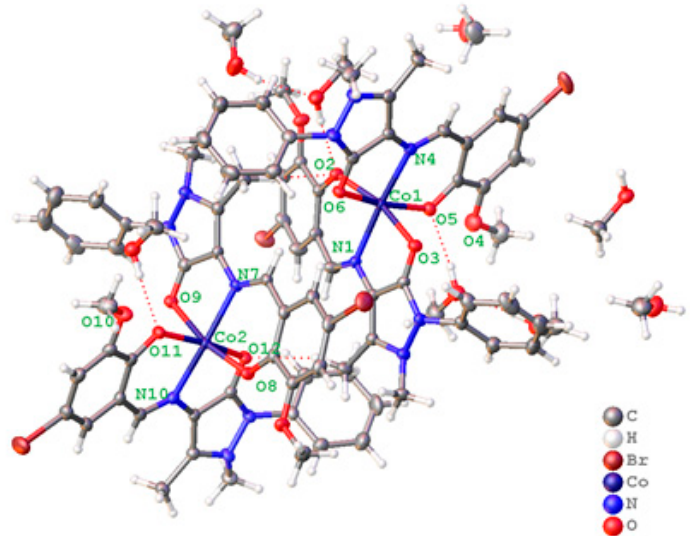
Figure 1. Single-crystal X-ray structure of 1 shown at 50% probability.